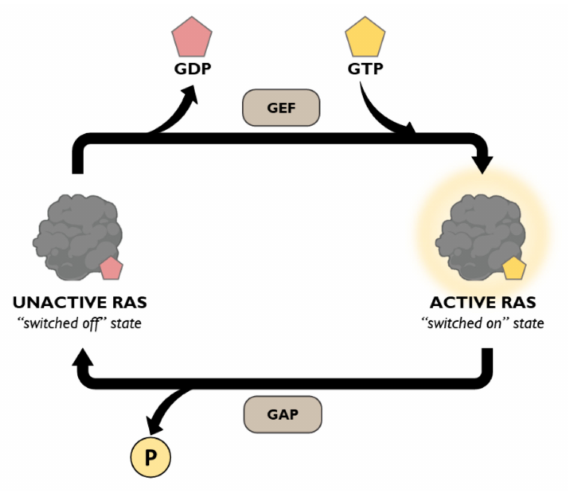
Figure 3. Diagram of Ras GAP/GEF Cycle. GAP proteins hydrolyse GTP to GDP, promoting Ras to reach an inactive state, while GEF proteins mediate the GDP-to-GTP exchange leading to Ras active